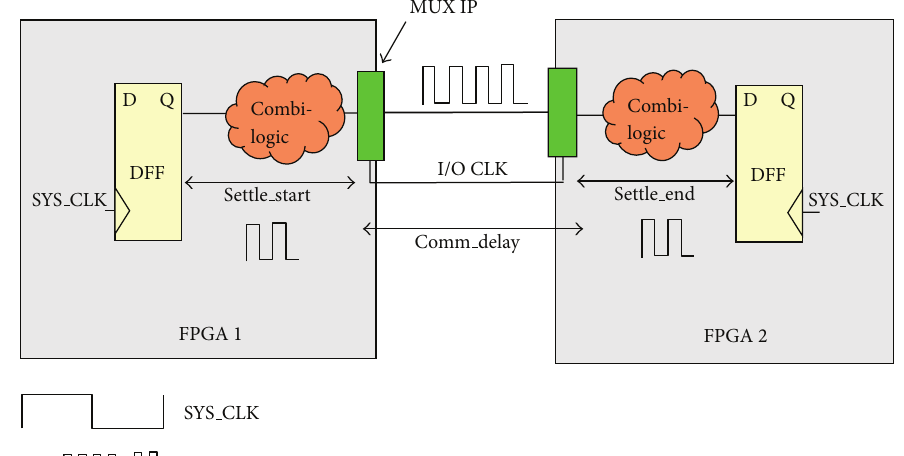
Figure 3: Clocking framework.